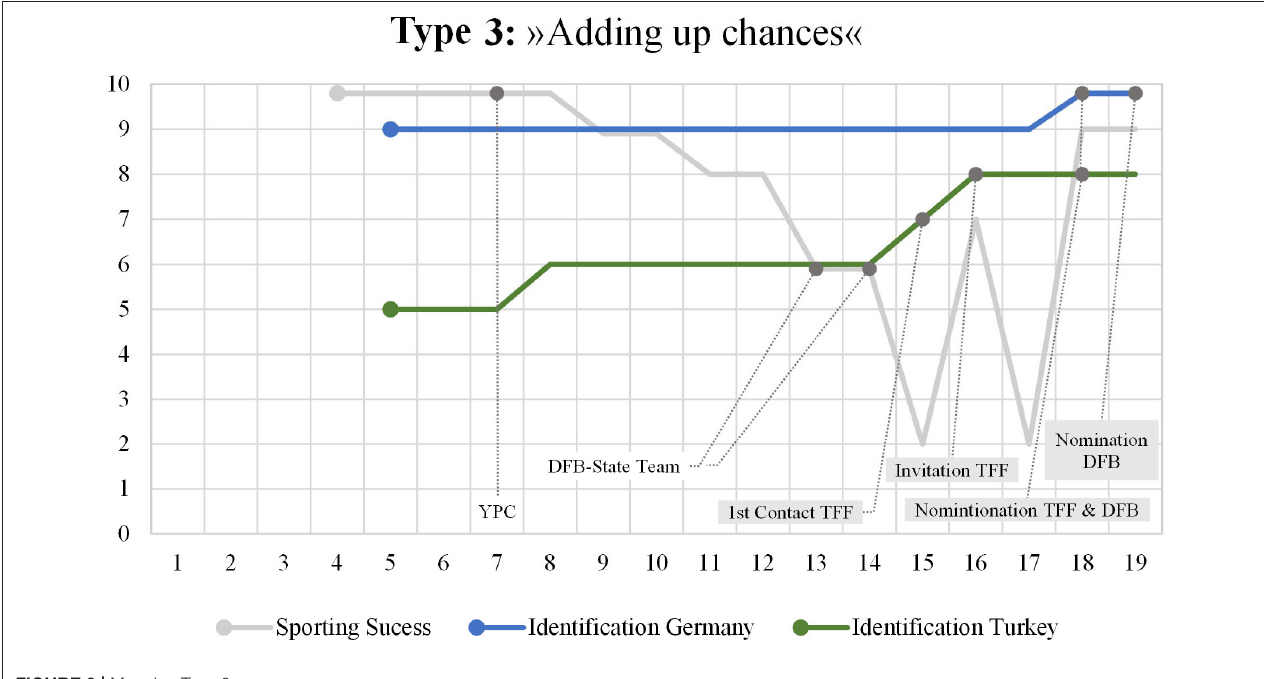
FIGURE 3 | Mapping Type